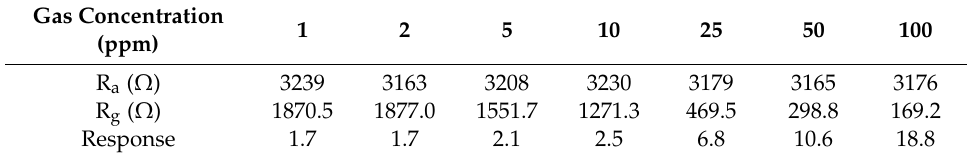
Table 4. Resistances and response of 0.05 M α -Fe 2 O 3 / ZnO NW vines according to gas